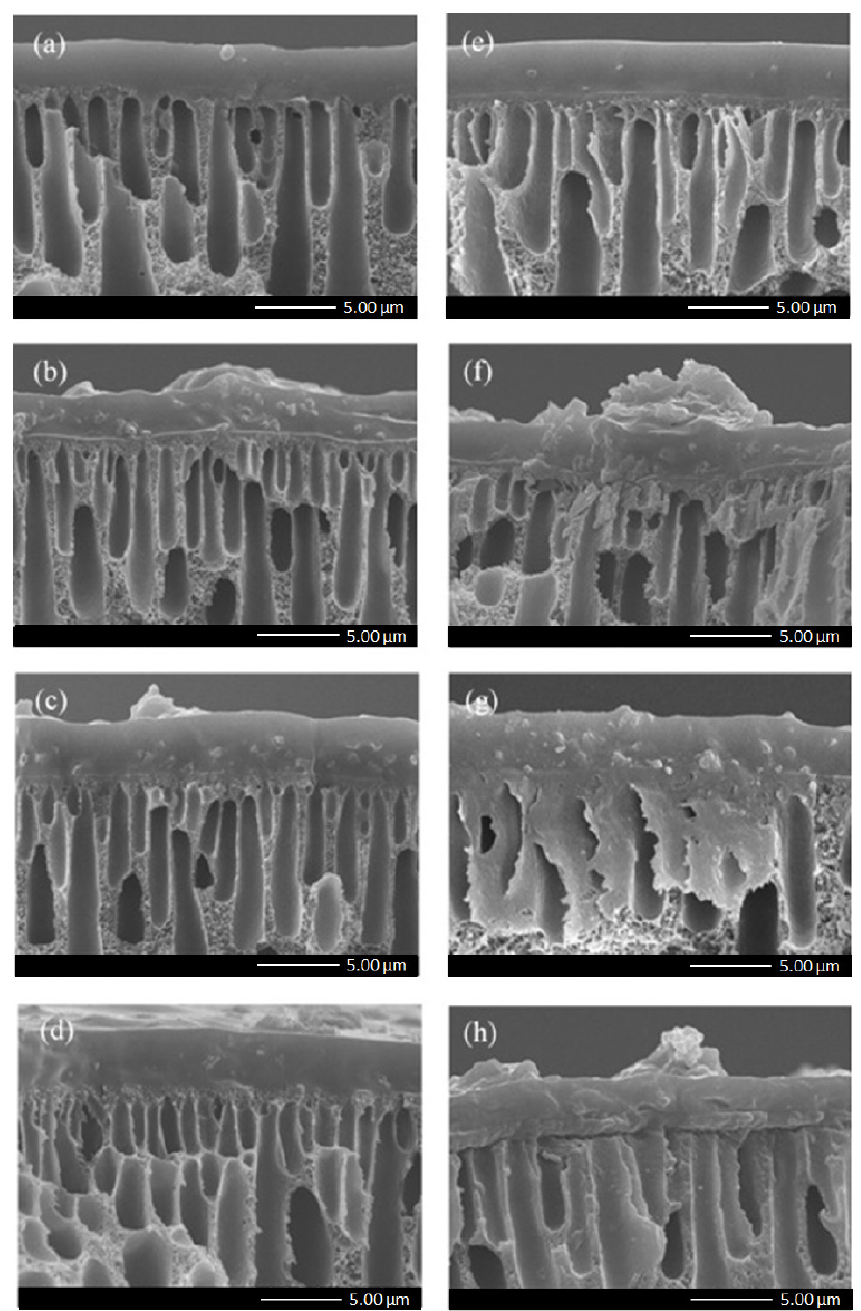
Figure 4. Cross-sectional view of MMMs incorporated with ( a ) 5, ( b ) 10, ( c ) 15, and ( d ) 20 wt.% of ZeY, respectively, and with ( e ) 5, ( f ) 10, ( g ) 15, and ( h ) 20 wt.% of Mo-ZeY, respectively. In Figure 5, when the particles were incorporated into the Pebax phase, both ZeY and Mo-ZeY showed good dispersion. However, at 15 wt.% loading, ZeY started to agglomerate, while for its counterpart Mo-ZeY, agglomeration occurred at 10 wt.% loading. Such an outcome may be caused by the higher interparticle affinity possessed by Mo-ZeY after aminosilane grafting, making the particles more susceptible to agglomeration at